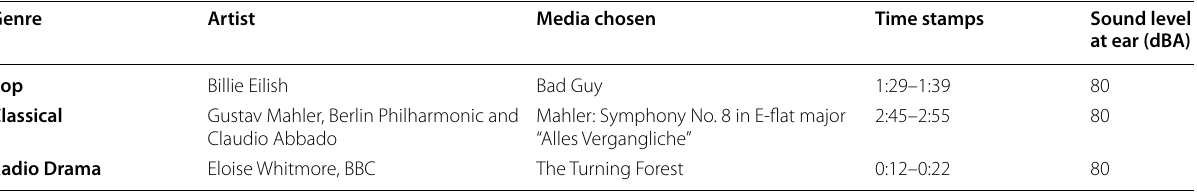
Table 3 Headphone media chosen to be used for the experiment, along with the exact timestamps